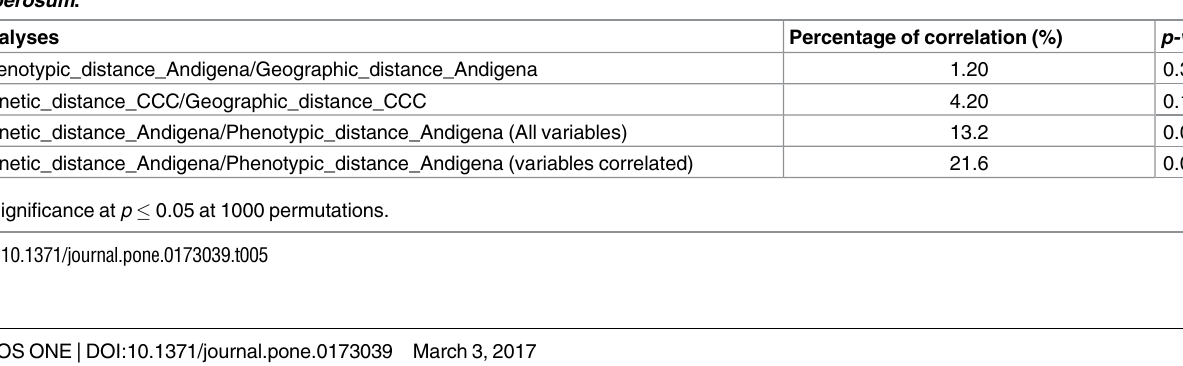
Table 5. Correlations between genetic, geographical and morphological distances in populations of the Colombian Central Collection of S . tuberosum . Analyses